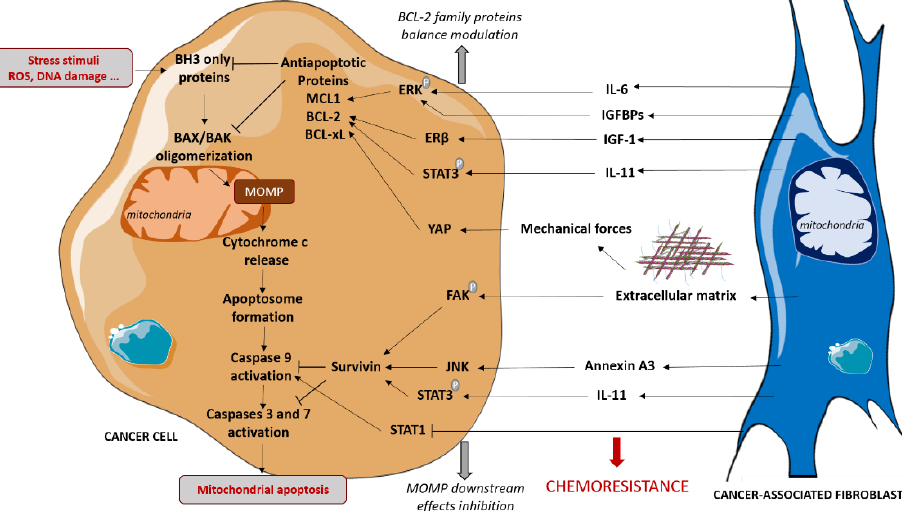
Figure 2. CAFs-mediated protection of cancer cells to mitochondrial apoptosis. CAFs induce chemoresistance in cancer cells by protecting them from mitochondrial apoptosis both by regulating anti-apoptotic proteins level and by limiting caspases activation. These effects are mediated by secretion of cytokines and growth factors and by extracellular matrix production, that is a feature of CAFs. IGF-1: Insulin-like Growth Factor-1, IGFBP: Insulin-like Growth Factor Binding Protein, IL: Interleukin, MOMP: mitochondrial Outer Membrane Permeabilization.